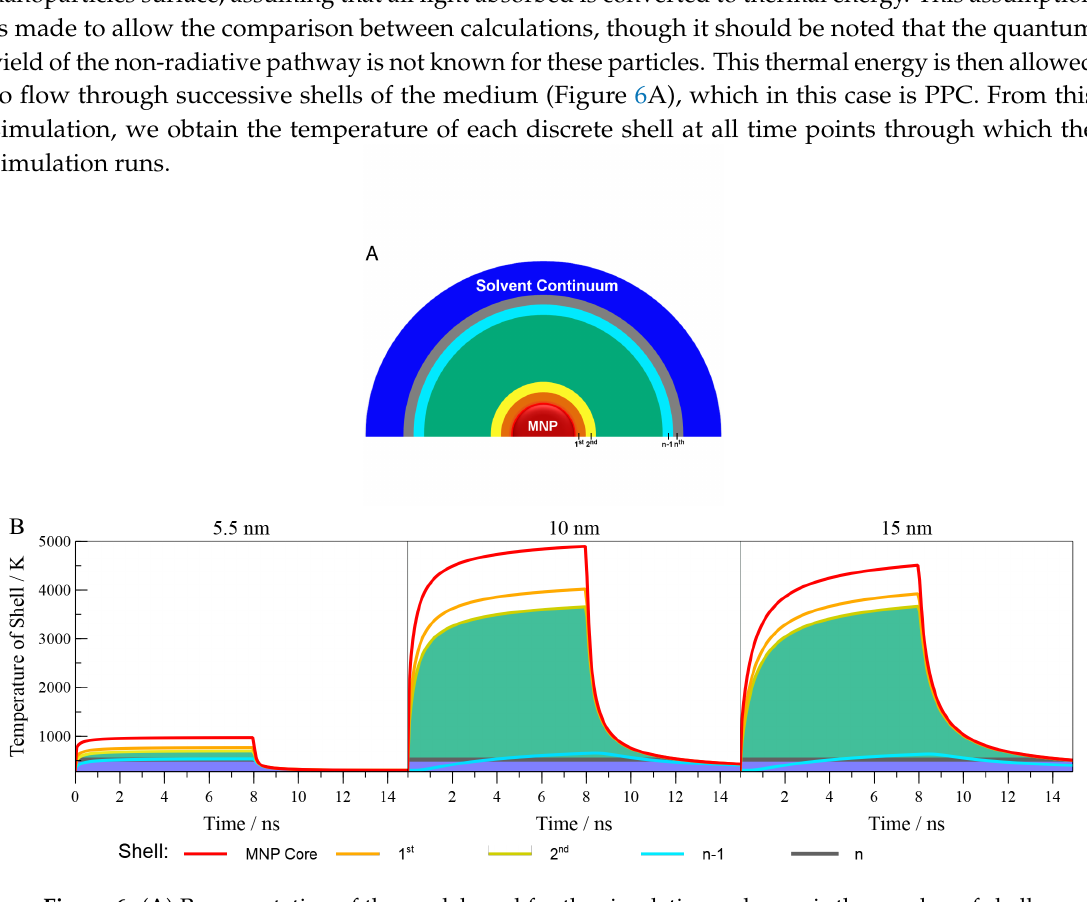
Figure 6. ( A ) Representation of the model used for the simulations where n is the number of shells through which the heat moves; ( B ) Results of the simulation showing the temperature of selected shells for 5.5 nm, 10 nm and 15 nm